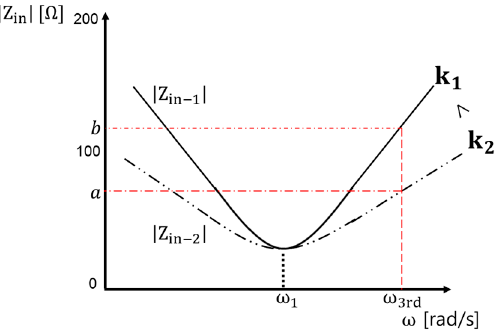
Figure 6. Conceptual graph of the input impedance of two systems depending on the value of coupling coefficients.